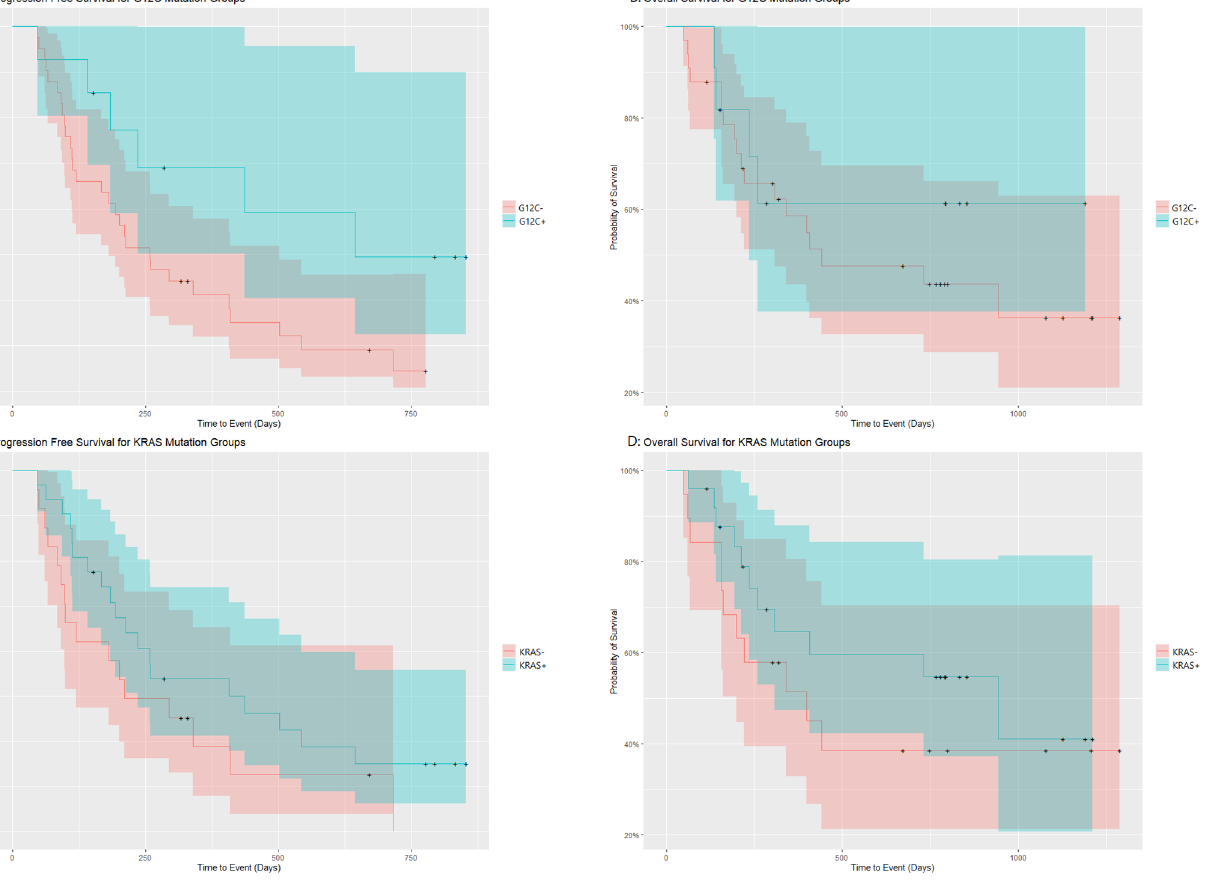
Figure 1. Kaplan–Maier curves of overall survival and progression-free survival split by G12C status and KRAS mutation status.